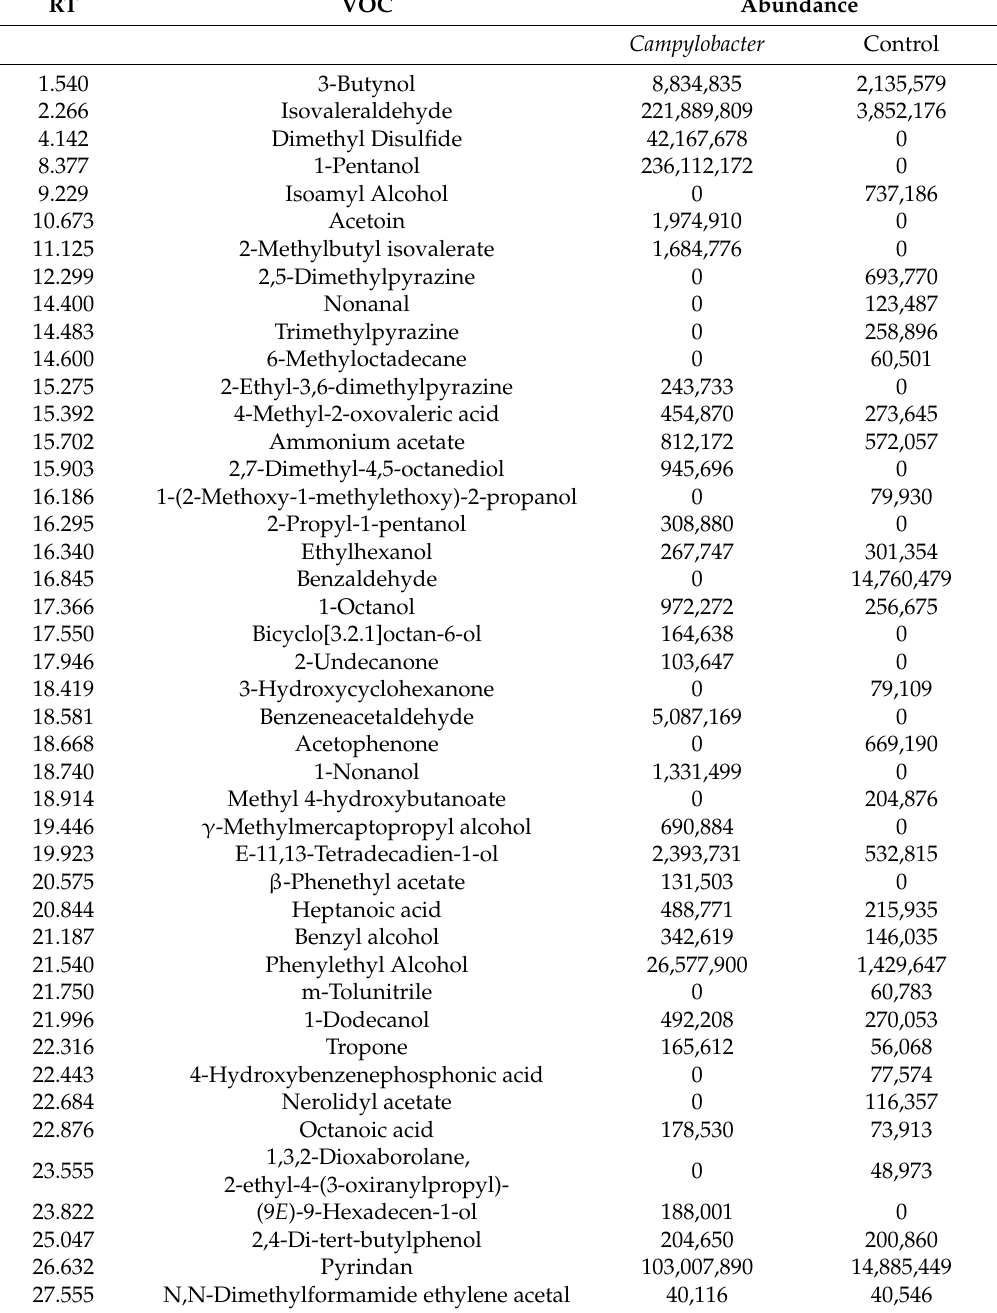
Table 3. List of VOCs for C. jejuni and control samples with their retention times (RT) and abundance in arbitrary units at time